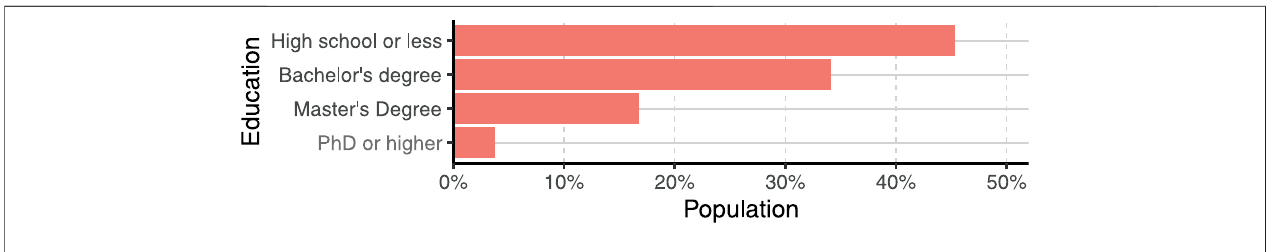
FIGURE 7 | List of educational level for the population.